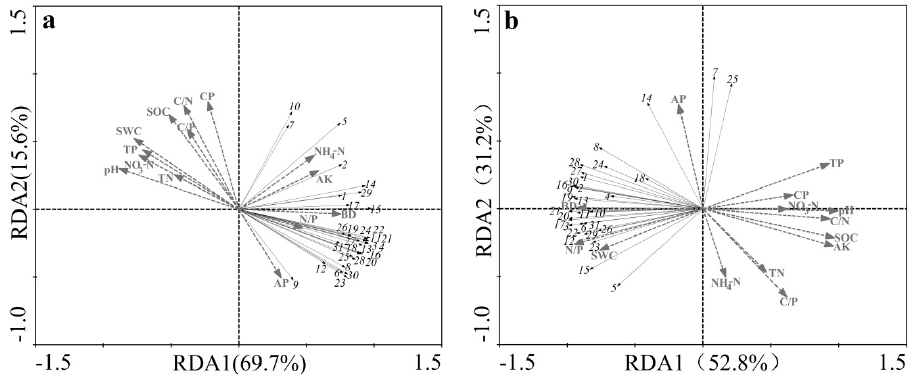
Figure 6. Redundancy analysis of the carbon source use patterns of microbial communities under ( a ) the secondary forest and ( b ) the Pinus yunnanensis plantation. The carbon substrates are: